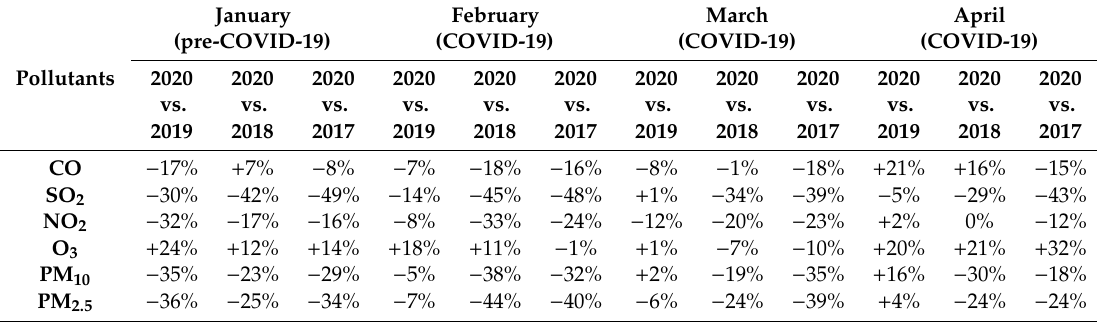
Table 3. Relative changes of ambient emissions of 2020 vs. 2017–2019 in each month. Negative and positive percentages indicate emission reductions and increases,